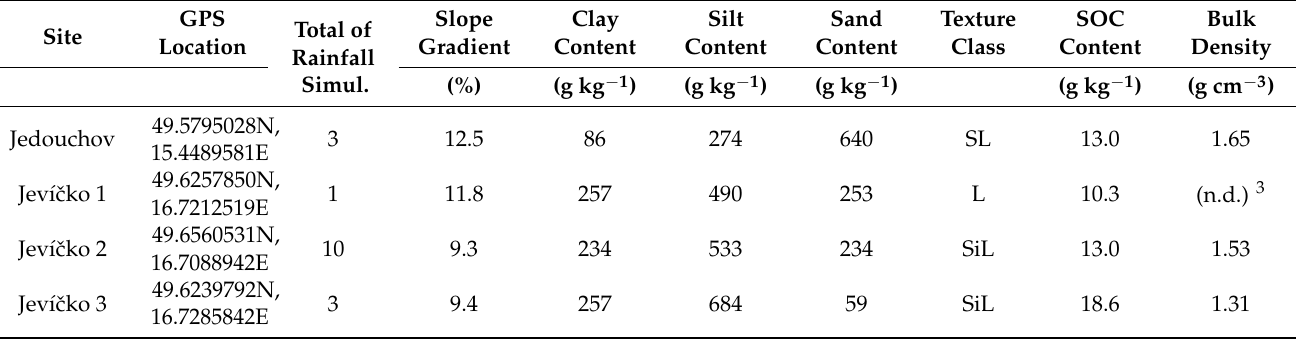
Figure 1. Location of the study sites within the Czech Republic. Note: This map is a modified version of the blank vector map provided by mapsvg.com [34], which is distributed under the terms and conditions of the Creative Commons Attribution 4.0 International (CC BY 4.0) license [35]. Table 1. Site and soil characteristics of each rainfall simulation site: GPS location, total of rainfall simulations from 2014 to 2020, slope gradient, mean clay (<2 µ m) content, mean silt (2 µ m to 50 µ m) content, mean sand (50 µ m to 2000 µ m) content, soil texture class according to [36], mean soil organic carbon (SOC) content, and mean soil bulk density.